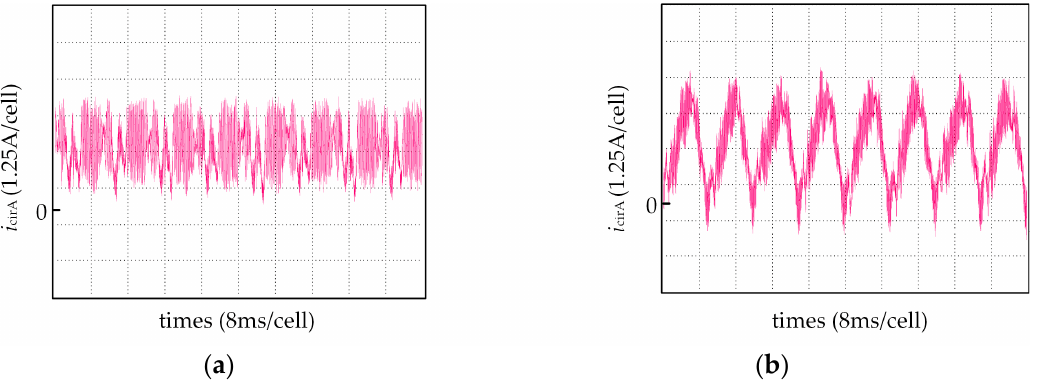
Figure 20. Experimental waveform of the circulating current fluctuation at cos φ = 0.954 ( N = 4). ( a ) The proposed modulation method, ( b ) the conventional modulation method.